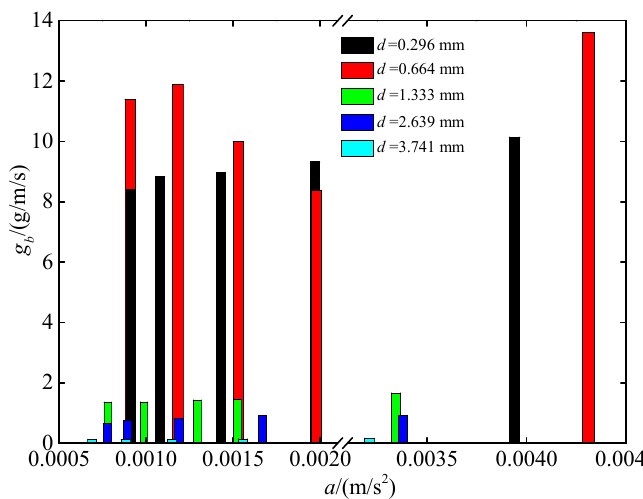
Figure 4. Variation of sediment transport rate of five uniform sands with different velocity skewness under unsteady flow conditions.